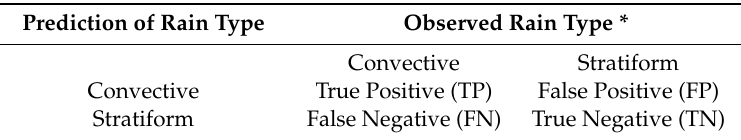
Table 4. The confusion